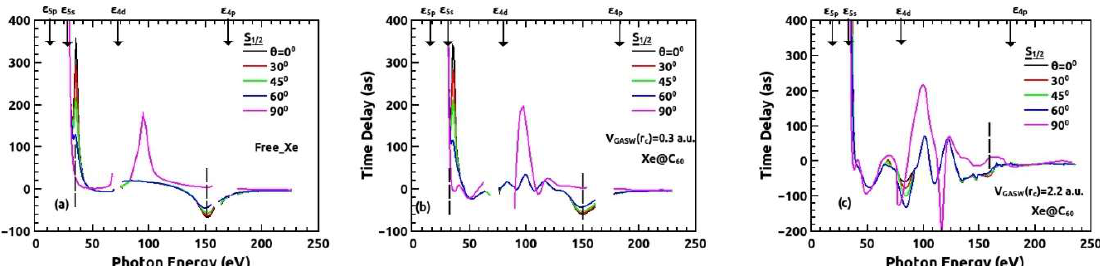
Figure 17. Spin average, angle-dependent time delay of photoionization from the 5s subshell of ( a ) free and confined Xe using the depths of ( b ) 0.3 a.u. ( middle panel ) and ( c ) 2.2 a.u. ( right panel ). Vertical lines denote the location of Cooper minima. Vertical arrows indicate the threshold values of the corresponding subshells used in the RRPA.